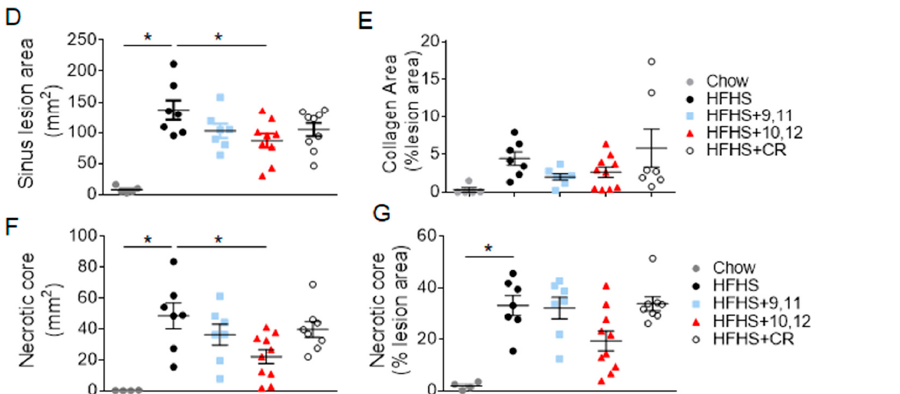
Figure 3. Atherosclerosis lesion size was decreased by 10,12 CLA, but not CR. Mice were fed either chow or HFHS diet for 12 weeks, then continued on the indicated diets for an additional 8 weeks. ( A , B ) Aortas were prepared en face ( A ), stained with Sudan IV, and lesions imaged and quantified using Image Pro Plus software ( B ). ( C – G ) Sections through the aortic sinus of the heart were stained with Movat’s pentachrome, and lesion area ( C ), collagen ( D ), and necrotic core area ( F – G ) was quantified using Image Pro Plus software. Data are presented as mean ± SEM, n = 5–10 mice/group. * p < 0.05 from HFHS control. Nutrients 2018 , 10 , x FOR PEER REVIEW